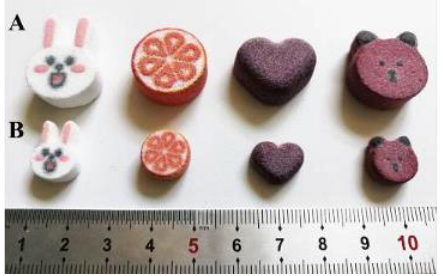
Figure 12. 3D printing of colorful cartoon dispersion tablets ( A ): 1000 mg strength; ( B ): 250 mg strength.